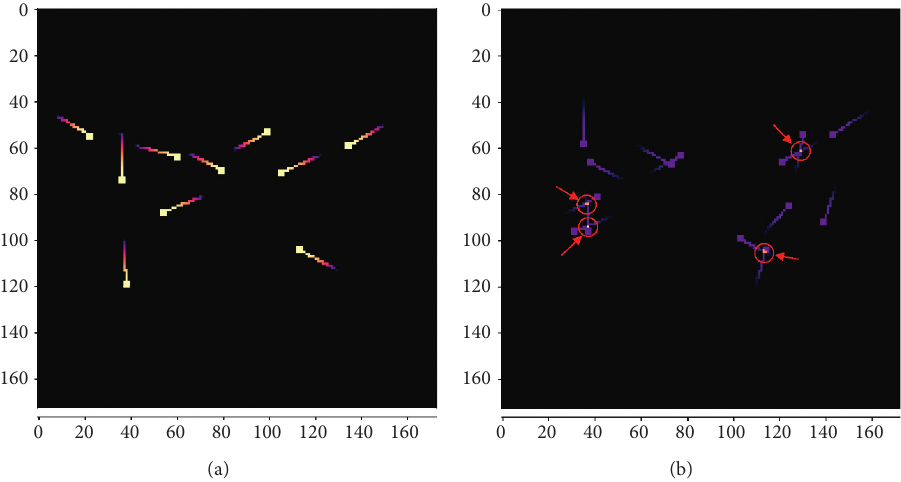
Figure 3: Channel of predicted trajectory: (a) no conflict scenario; (b) conflict